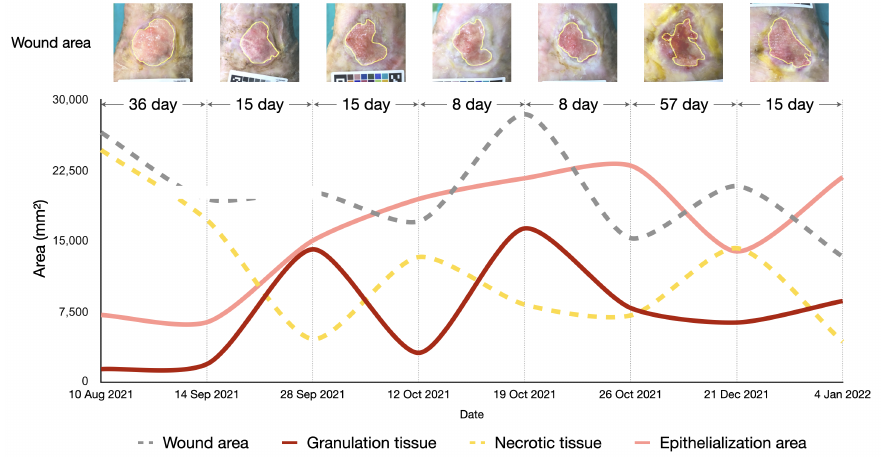
Figure 10. Assessment of wound healing over time using our algorithms with a patient who vis- ited the wound clinic seven times. The area of the wound, epithelialization, granulation tissue, and necrotic tissue can be derived from the wound images. The resulting information can be used by physicians to improve wound